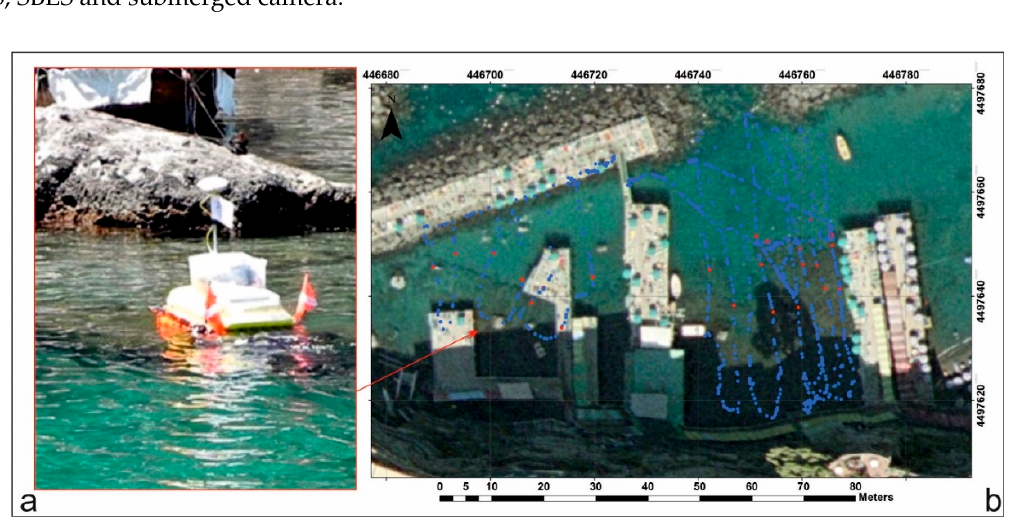
Figure 12. ( a ) 2D visualization of the sea floor digital model of the study area—Sorrento Marina Grande (Naples, Italy); ( b ) 3D visualization of the same sea floor.